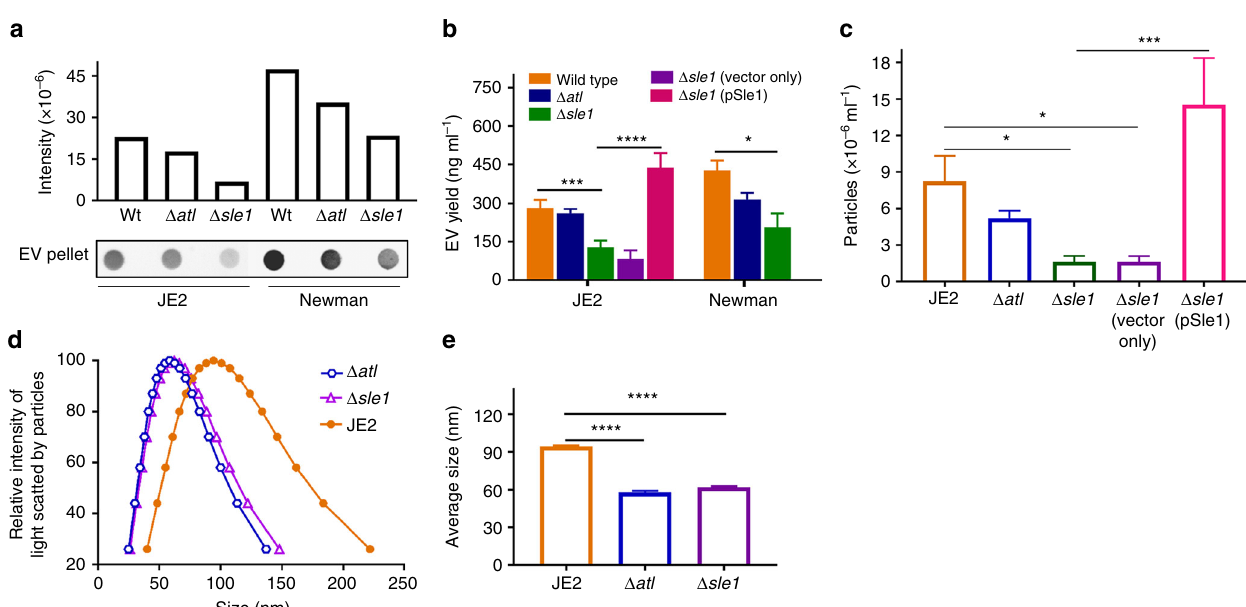
Fig. 4 The autolysin Sle1 promotes EV biogenesis. a EV production from JE2 and different autolysis mutants ( Δ atl and Δ sle1 ) was evaluated by dot-blotting EV suspensions, b by quanti fi cation of total EV protein abundance, or c by EV quanti fi cation using nanoparticle tracking analysis. d The size distribution and e average size of EVs isolated from JE2 and the Δ atl and Δ sle1 mutants were measured by dynamic light scattering. The dot immunoblot assay was repeated at least twice with similar results; a representative blot is shown. EV protein yield and EV particle quanti fi cation experiments were calculated from at least three independent experiments and expressed as mean ± s.e.m. The data were analyzed using one-way ANOVA with Dunnett ’ s multiple comparison test (Fig. 4b, c, e), For all panels, * P < 0.05, ** P < 0.01, *** P < 0.001, **** P < particles per ml compared to untreated WT EVs. Electron micrographs of bacterial cells treated with PenG (Fig. 3j) or carrying a pbp4 mutation (Fig. 3k) showed EVs being released or budding, respectively, from the cell membrane. Taken together, our data indicate that S. aureus EV production is inversely proportional to the degree of PGN cross-linking.